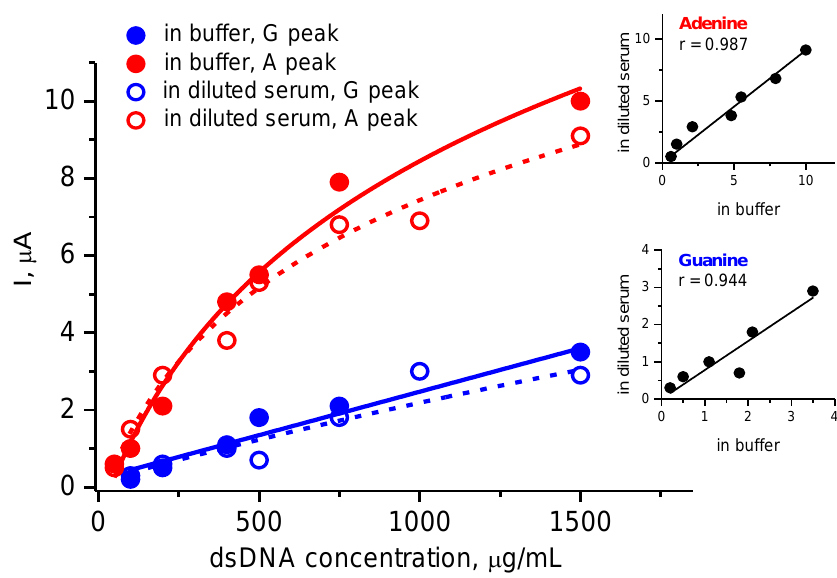
Figure 4. The dependences of the current intensities of the DPV peaks for electrooxidation of the guanine (blue) and adenine (red) residues on the concentration of dsDNA in a buffer media (open symbols) or dsDNA spiked into diluted human serum (closed symbols). Conditions: measurements were carried out with the SPE/(P n BMA 40 - b -PDMAEMA 120 + MWCNT_2) construct; time of DNA incubation was 15 min; human serum was firstly diluted 10 times with electrolyte buffer (100 mM potassium phosphate with 50 mM NaCl, pH 7.4) then was spiked with a 50 – 1500 µg/mL dsDNA solution. Insets: correlations between the DPV responses of the guanine and adenine residues measured in pure buffer and in the presence of human serum.